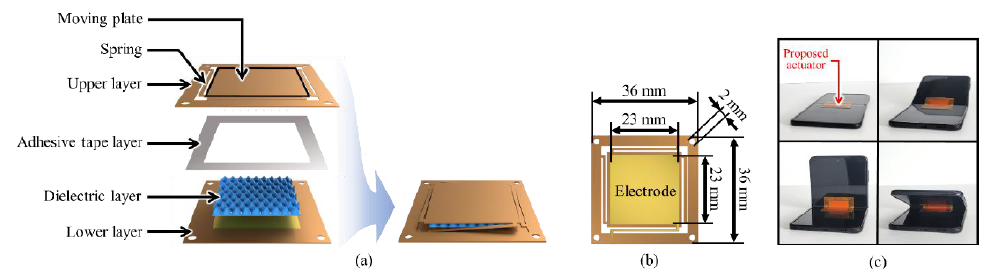
Figure 7. Proposed flexible vibrotactile actuator based on dielectric elastomer: overall structure of the proposed actuator and assembled vibrotactile actuator ( a ); the bottom surface of the upper layer ( b ); proposed actuator attached to a foldable smartphone ( c ) (source: